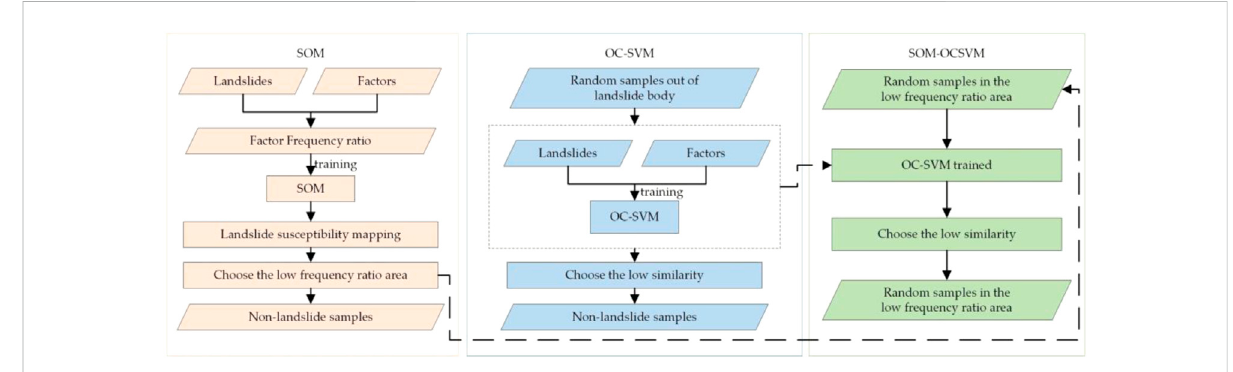
FIGURE 4 Flowchart of non-landslide dataset